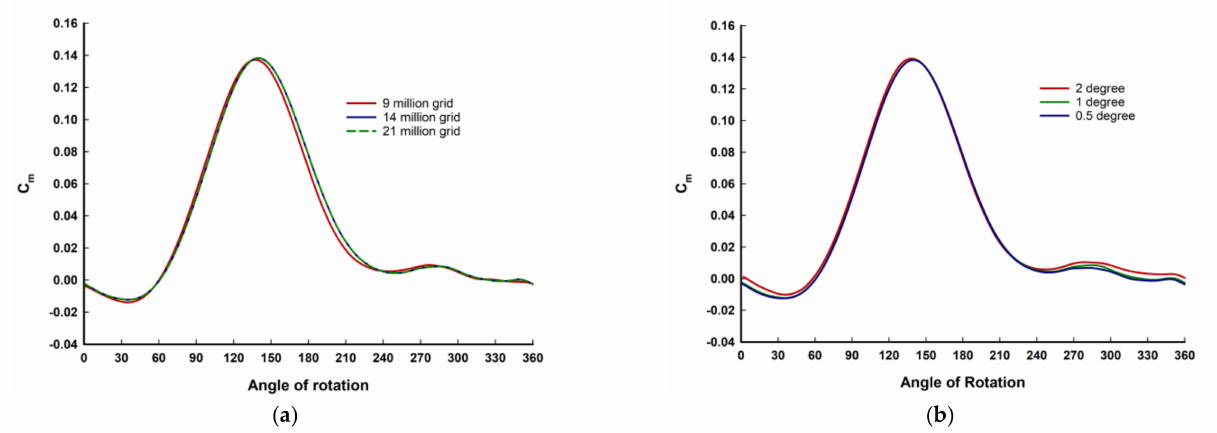
Figure 4. Moment coefficient (Cm) plot for a single blade indicating ( a ) grid independence, ( b ) time step